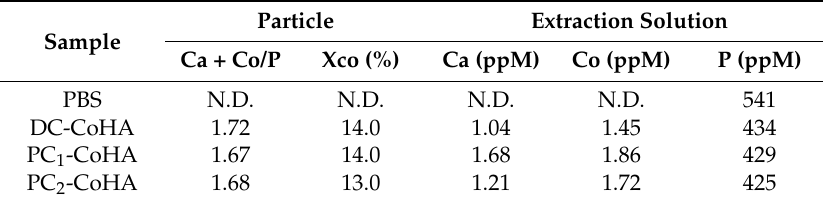
Table 3. Element ratios inside CoHA particles and ion release concentration in CoHA immersed